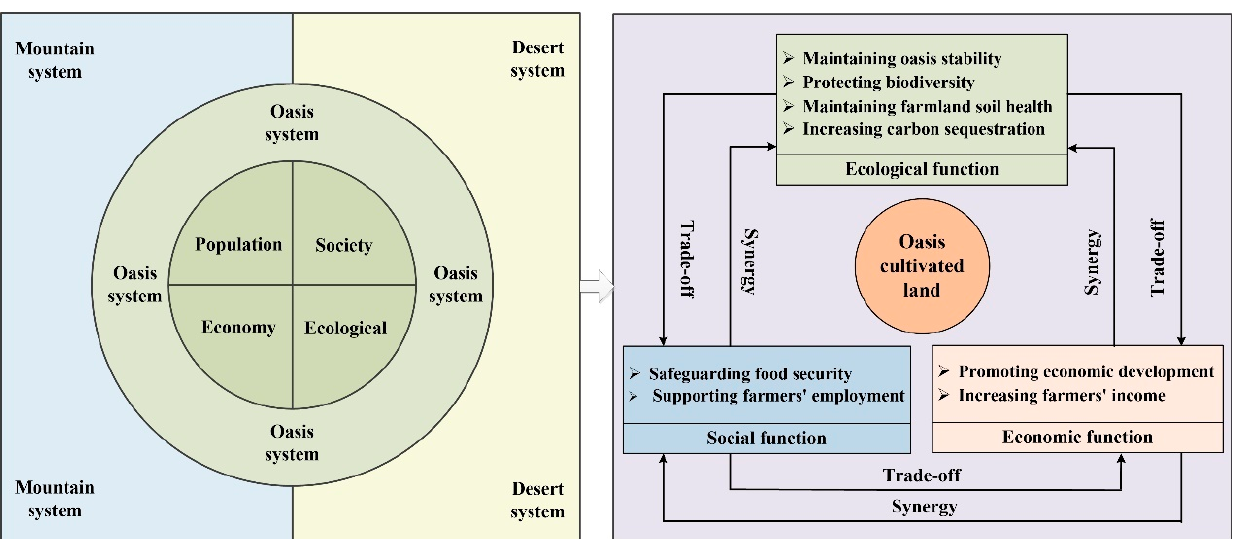
Table 1. Evaluation index system of oasis cultivated land function in Xinjiang.